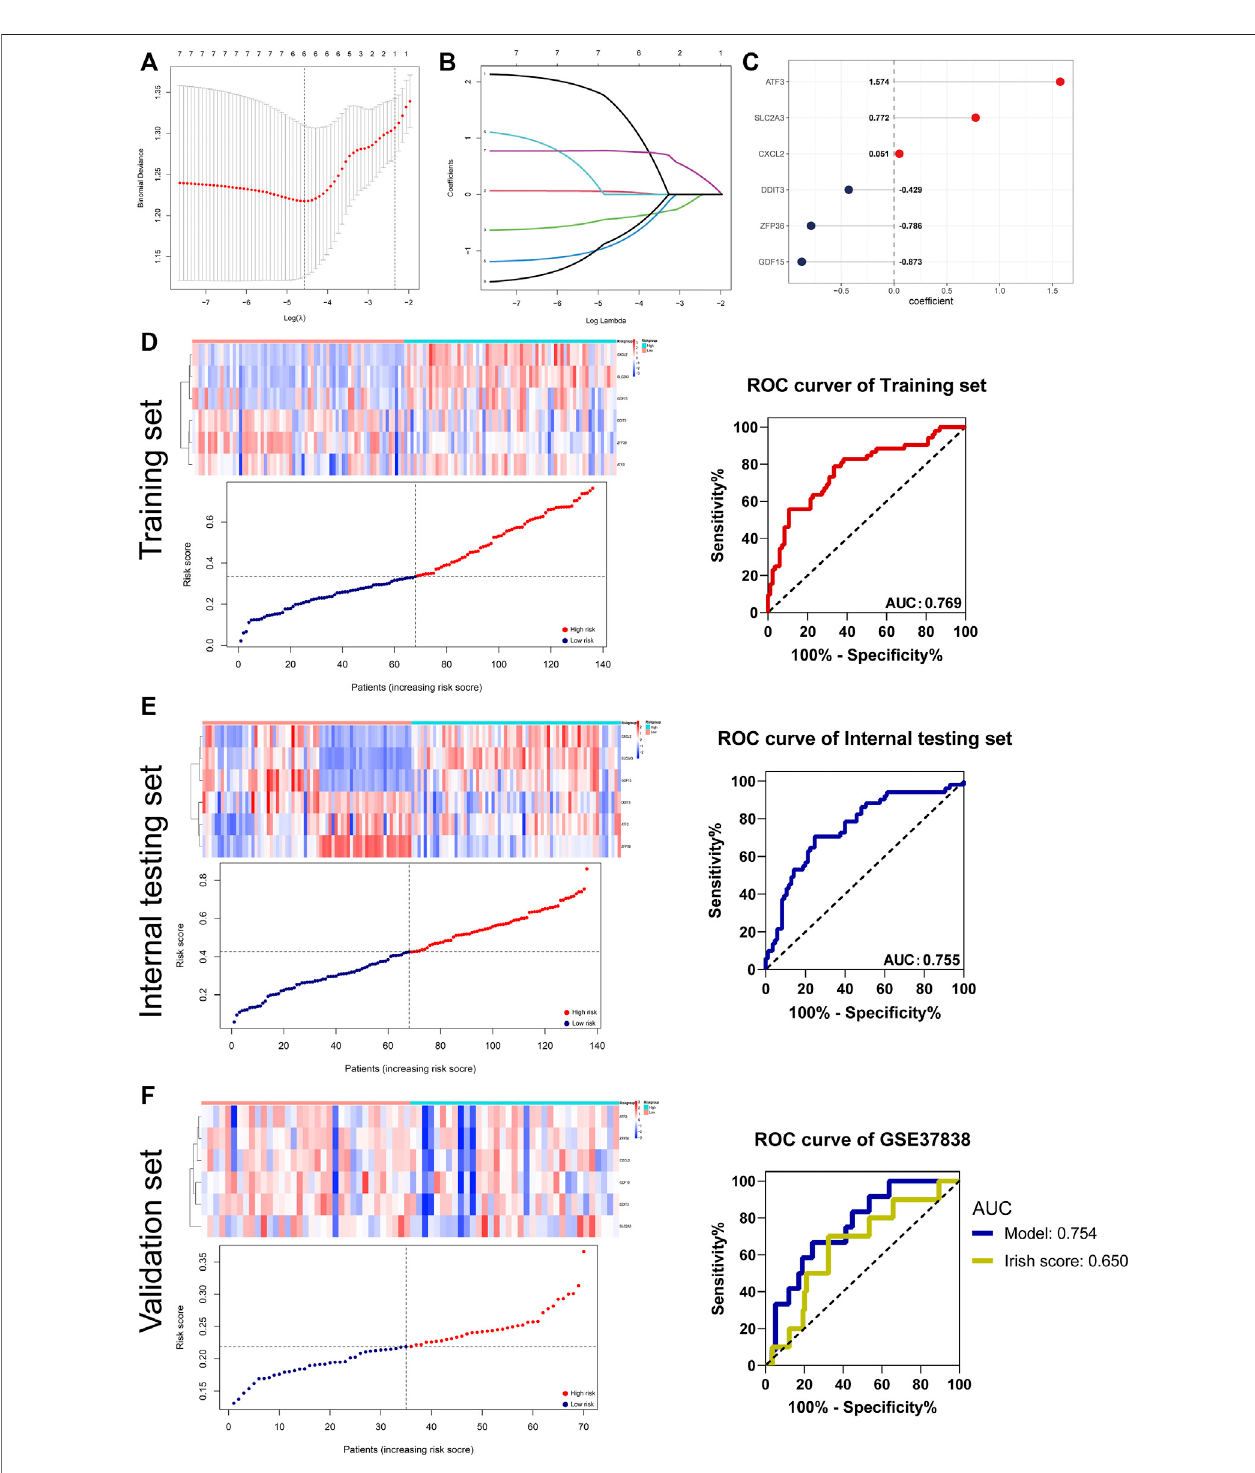
FIGURE7| Establishmentand validationoftheDGF predictive signature. (A,B) DGF predictive signature wasestablished from eight DFRGs.The lambda.min was selected as the best lambda value of the model. (C) LASSO coef fi cients of candidate genes in the signature. (D – F) Evaluating the performance of the signature in the training set, internal testing set, and validation set (GSE37838). The heatmaps showing gene expression of six genes (CXCL2, SLC2A3, GDF15, DDIT3, ZFP36, and ATF3) in the signature. Patients ’ distribution based on themedian riskscore. ROCcurvespresentingthe ef fi cacyofthe signature for predictingDGF in IRIpatients. Area under the ROC curve (AUC) was calculated and compared.